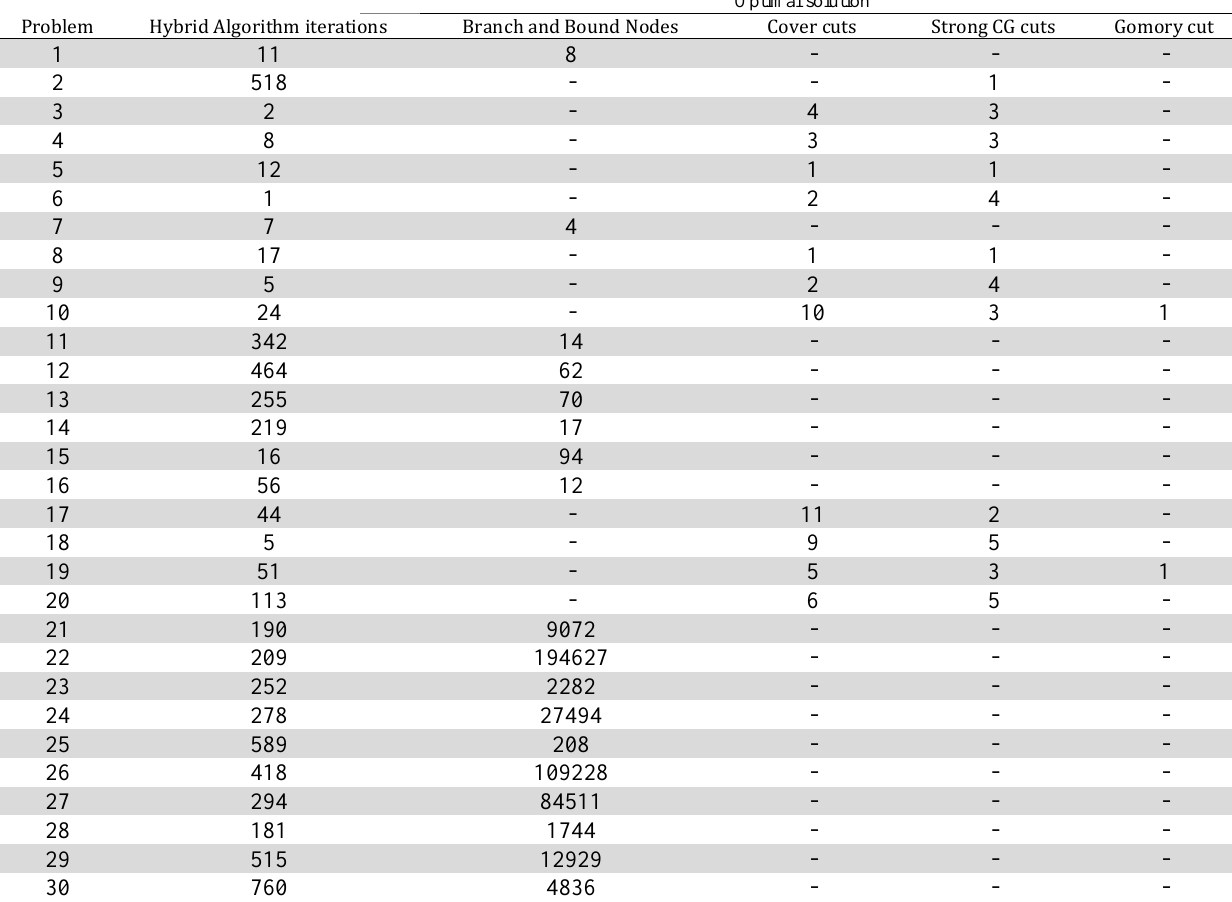
Table 4 The results of hybrid algorithm iterations, branch and bound nodes, and number of cuts